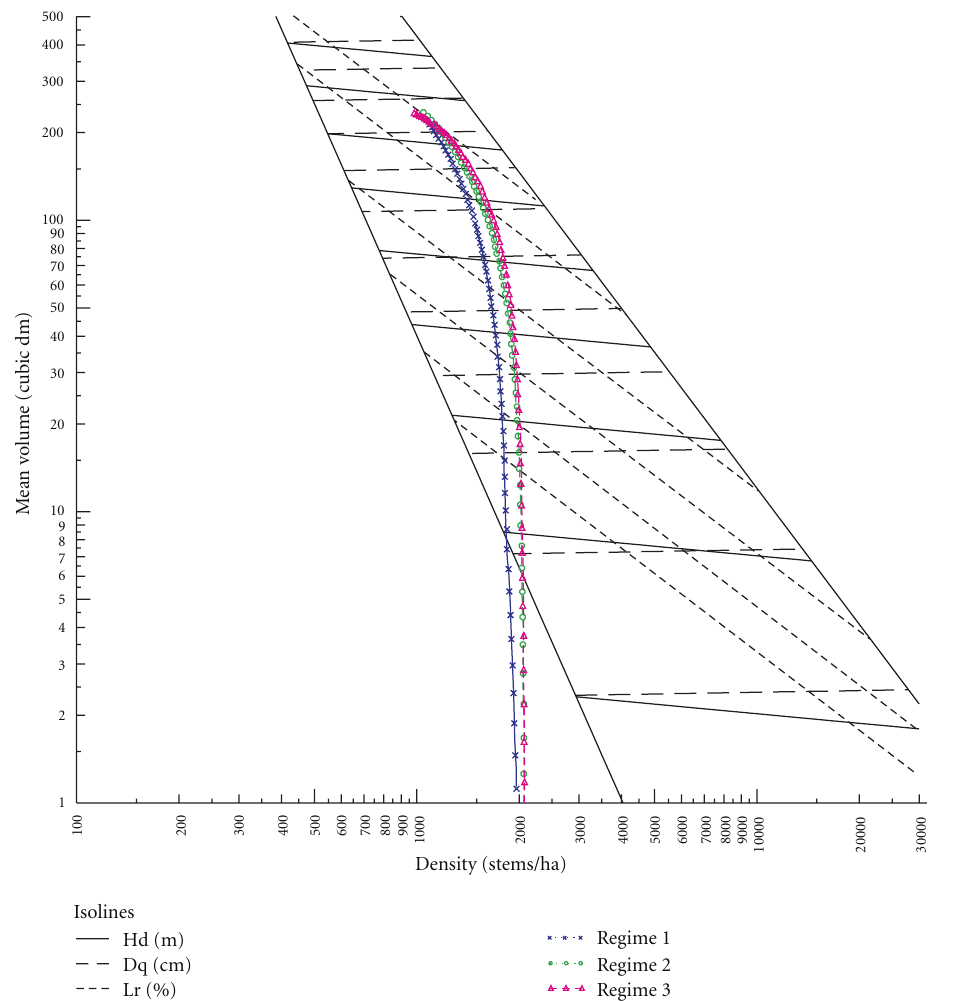
Figure 1: Seventy-five year temporal size-density trajectories for upland black spruce plantations situated on low-medium quality sites (site index = 14): Regime 1—no FVM treatment applied; Regime 2—FVM treatment with an expected e ff ect of a 15.7% height gain at age 7; and Regime 3—FVM applied with an expected e ff ect of a 40.0% height gain at age 7. Graphically, illustrating the (1) isolines for mean dominant height (Hd; 4–20 m by 2m intervals), quadratic mean diameter (Dq; 4–26 cm by 2cm intervals), and mean live crown ratio (Lr; 35, 40, 50, ... , 80%), and (2) crown closure line (lower boundary of the size-density space as delineated by the lower left diagonal solid line) and the self-thinning rule (upper boundary of the size-density space as delineated by the upper right diagonal solid